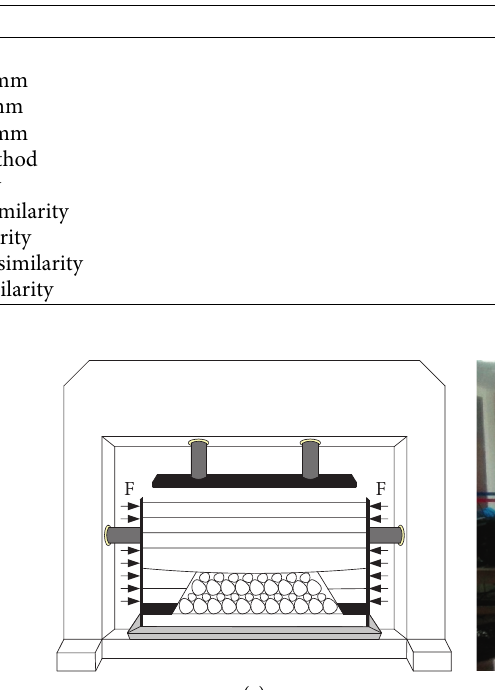
Table 2: Model design parameters.